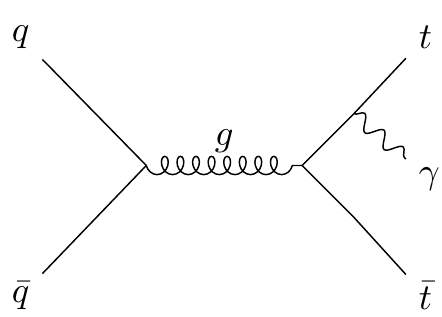
Figure 5 . Typical t ¯ t + γ Feynman diagram, shown with final state radiation (FSR).